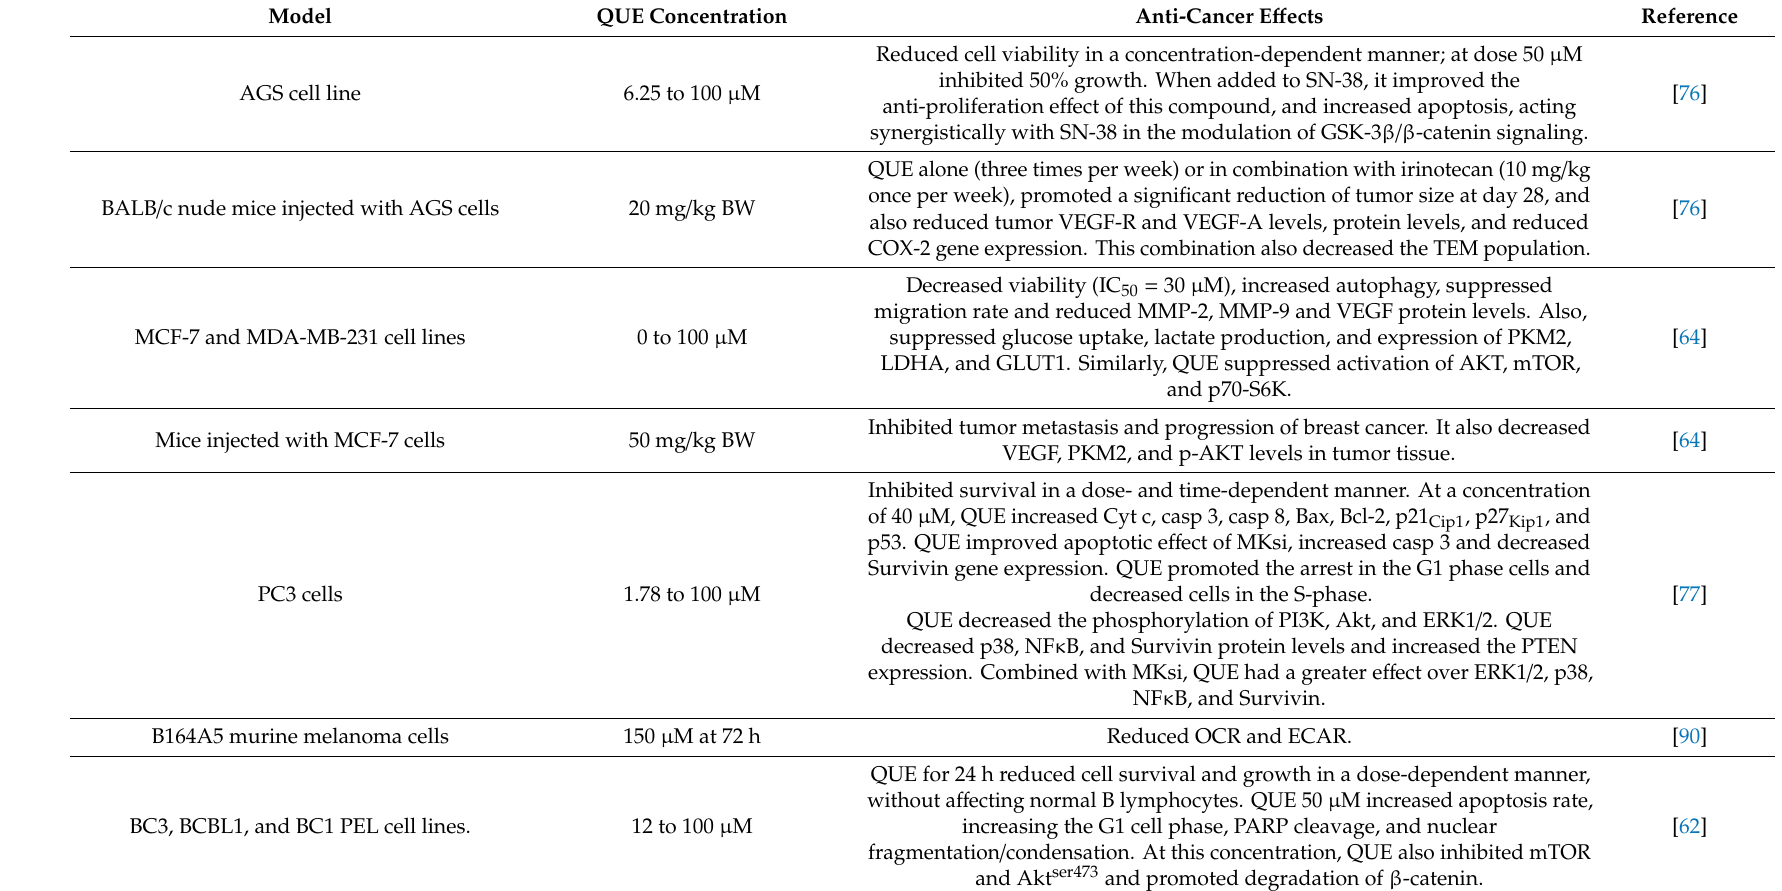
Table 1. Anti-cancer e ff ects of Quercetin